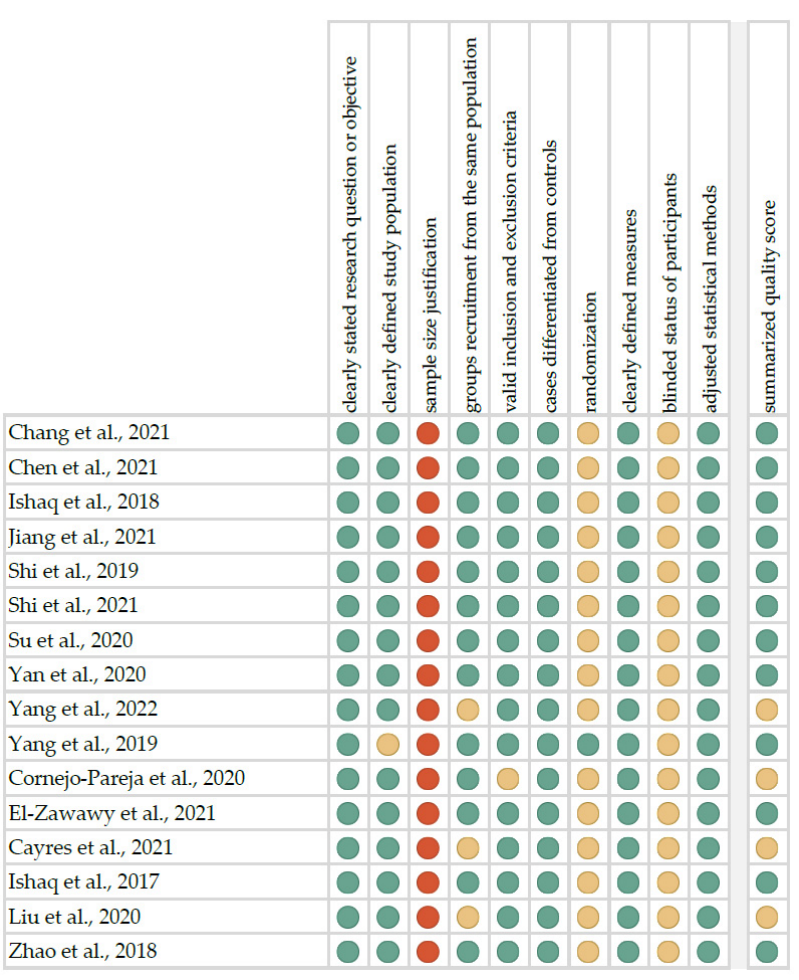
Figure 7. Quality assessment, including the main potential risk of bias (risk level: green—low, yellow—unspecified, red—high; quality score: green—good, yellow—intermediate, red—poor) [30– 45].